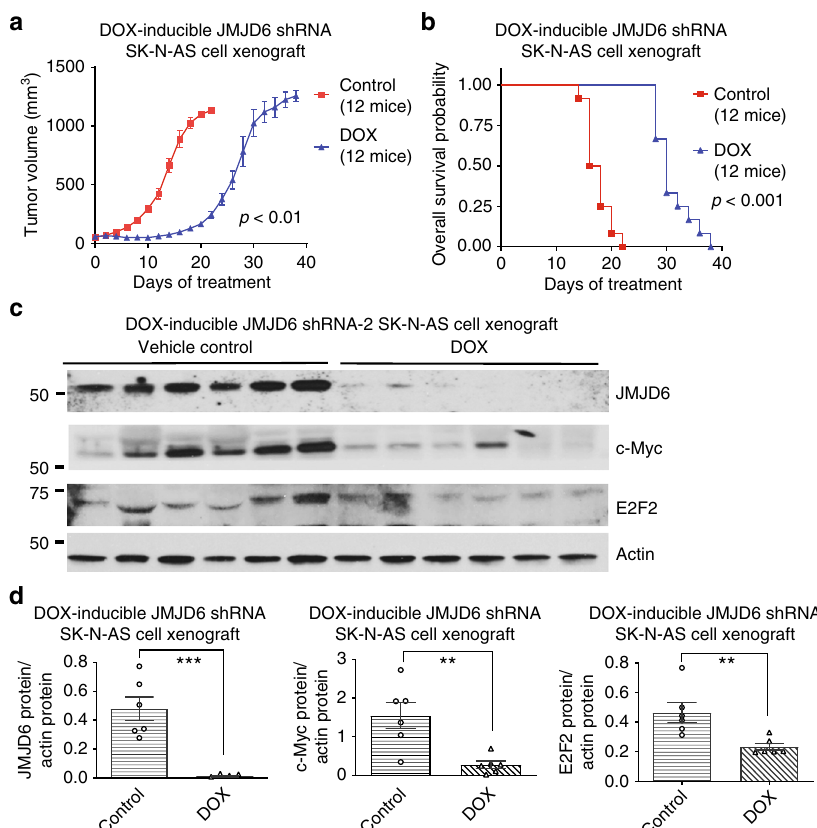
Fig. 5 JMJD6 is important for E2F2 and Myc expression and tumor progression in vivo. a DOX-inducible JMJD6 shRNA-2 SK-N-AS cells were xenografted into nude mice. When tumors reached 0.05 cm 3 in volume, the mice were divided into two groups, and fed with food with or without 600 mg/kg of DOX. Tumor growth was monitored every other day, and the mice were culled when tumor reached 1 cm 3 . Error bars represent standard errors (** p < 0.01, two- tailed paired Student ’ s t test). b Survival curve analysis showed the probability of mouse overall survival. Two-sided log-rank test was used to generate the p- value. c , d Protein was extracted from the tumors from the mice, and subjected to immunoblot analysis of JMJD6, c-Myc, and E2F2 protein expression ( c ), followed by quanti fi cation against the house-keeping actin using Quantity One software ( d ). Error bars represent standard errors (** p < 0.01, *** p < 0.001, two-tailed unpaired Student ’ s t test). Source data are provided as a Source Data fi